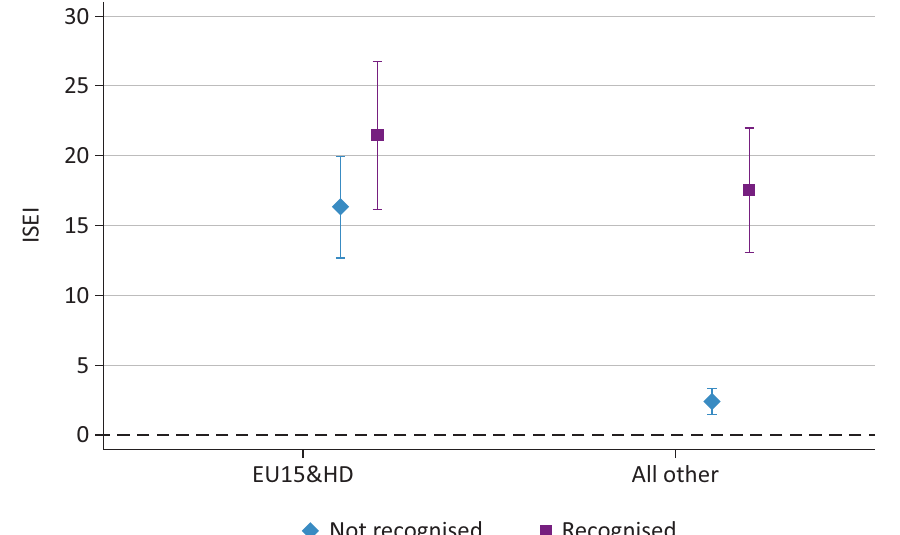
Figure 2. ISEI returns to post-secondary degree on the first job in Italy by origin and recognition (controls included, 90% C.I.). gin. Due to the small number of immigrants who have their post-secondary degree recognized on arrival (see ta- ble A2 in Annex), the areas of origin are simplified in a di- chotomous variable distinguishing between immigrants from Western countries and those from all other coun- tries. The choice is justified by the fact that returns to education on the first job are only slightly different by area of origin, apart from the Western/non-Western di- vide (see Figure